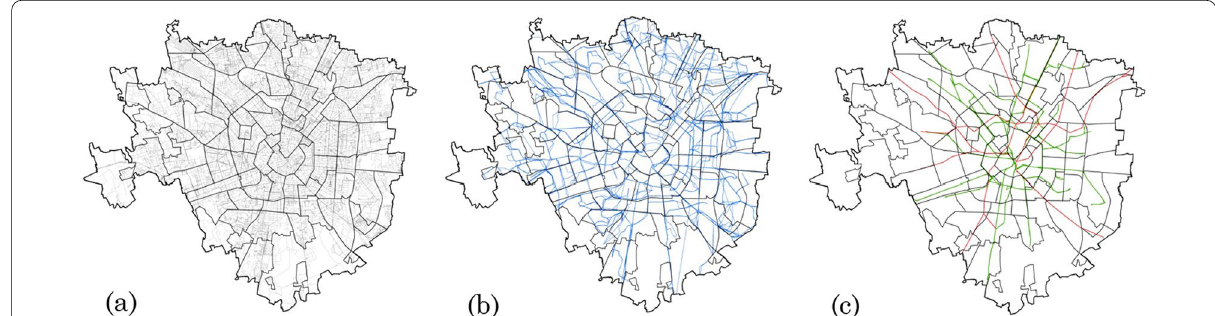
Fig. 4 Walking network ( a ), bus network ( b ) and tram and metro network ( c ) in the city of